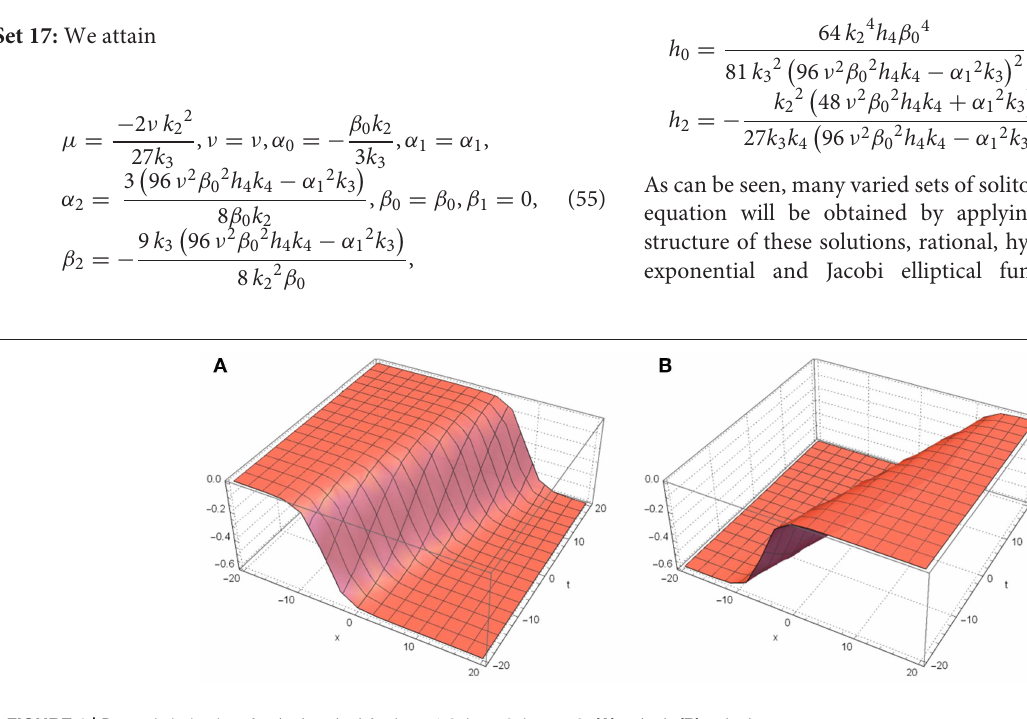
FIGURE 1 | Dynamic behavior of u 1 ( x , t ), u 2 ( x , t ) for k 2